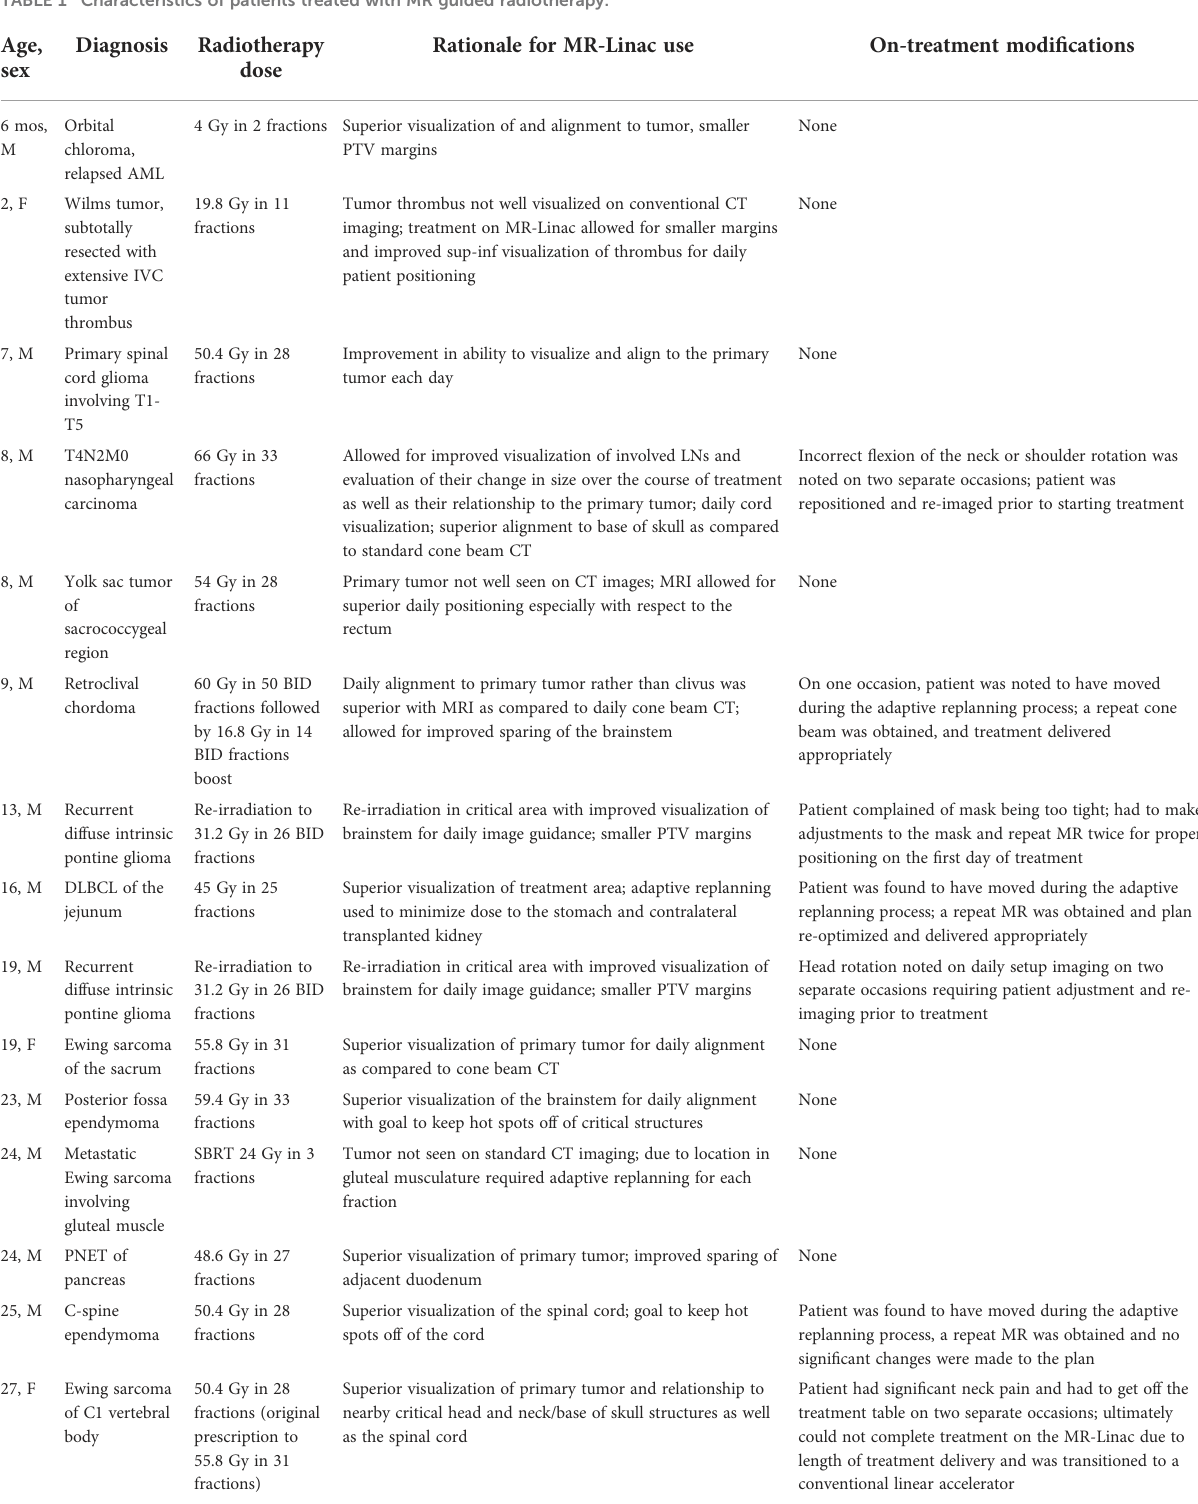
TABLE 1 Characteristics of patients treated with MR guided